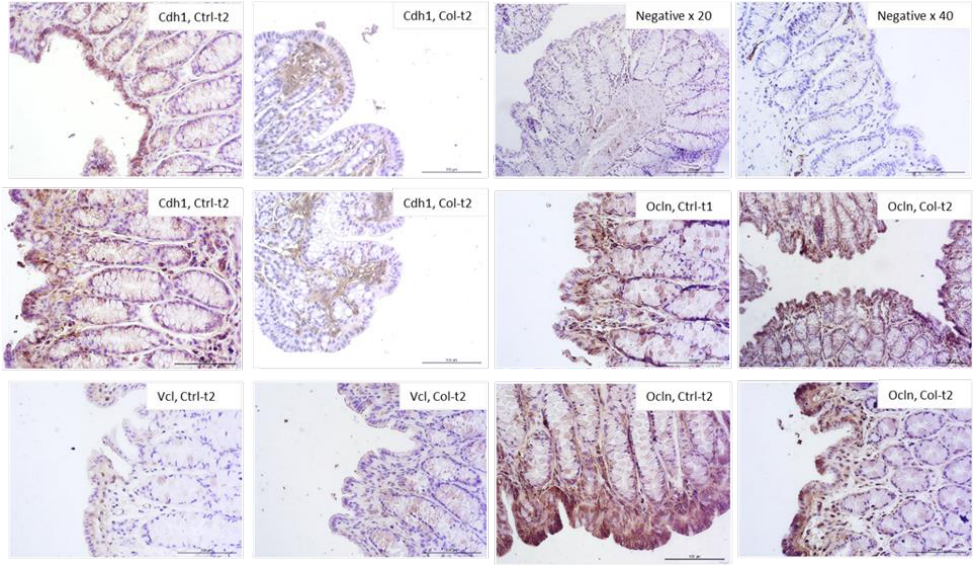
Figure 7. Representative pictures of protein expression of intercellular junctions. Only those where the differences were most apparent were selected (objective magn. ×20, Leica DM5000B, Wetzlar, Germany). Table 2. Results of a simple correlation between CDH1 , CDH2 , CTNNB1 , CX43 , VCL , OCLN , HP